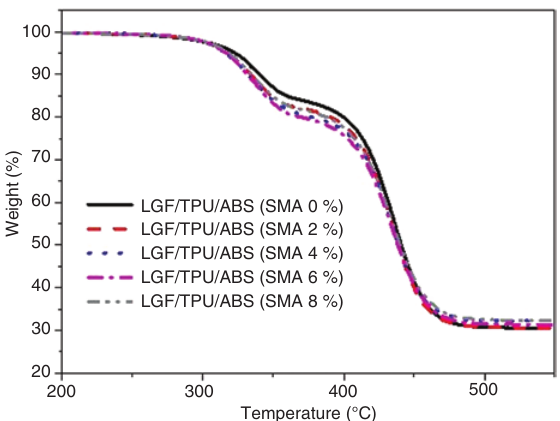
Figure 4 Effects of compatibilizer content on tan δ of the